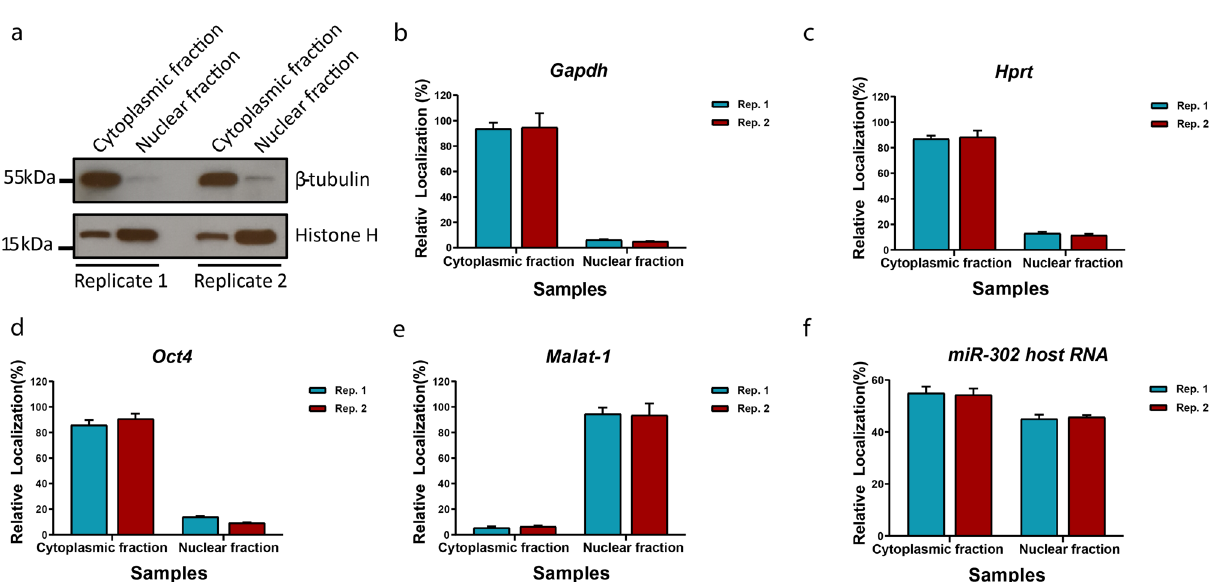
Figure 3. Distribution of the mmu-miR-302 host RNA in the cell. ( a ) Western blot analysis of sub cellular fractions for two biological replicates showing little β-tubuli in the nucleus and high enrichment of histone H3 in the nucleus indicating efficient separation of cytoplasmic and nuclear compartments. Equal amounts of the fractions were loaded. The original full picture of the entire Western blot membranes are shown in the suplemental Figure S2. QRT-PCR quantification of the Gapdh ( b ), Hprt ( c ) and Oct4 ( d ) as cytoplasmic refernce RNA transcript and Malat-1 ( e ) as nuclear reference RNA confirmed efficient fractionation. MiR-302 host RNA ( f ) found in both cytoplasmic (> 54%) and nucleus (> 45%) indicating it is significantly exported to the cytoplasm, however its accumulated level in the cytoplasm is lower and not comparable to the reference RNA transcripts. Bar plots show the average of the transformed Ct (2 -Ct ) calculated to visualize the relative localization level of each respective transcript in percentage of the cytoplasmic and nuclear fractions of the same sample. Error bars representing ± SD, n = 3 and, p < 0.05 as significance bodies against the cytoplasmic protein β-tubulin and nuclear specific protein histone H3 (Fig. 3a). Addition- ally, the fractionation efficiency was confirmed by qRT-PCR quantification and distribution analysis of several housekeeping RNA transcripts including Gapdh (Fig. 3b) and Hprt (Fig. 3c) as cytoplasmic RNA species. Oct4 (Fig. 3d) was used both as cytoplasmic RNA and as stem-cell specific marker. Malat-1 (Fig. 3e) was used as nuclear RNA control. Even though not 100% pure, the fractions were greatly enriched. Importantly, the distribu- tion of Malat-1 RNA proofed that the cytoplasmic fraction contained very little nuclear RNA. We found more